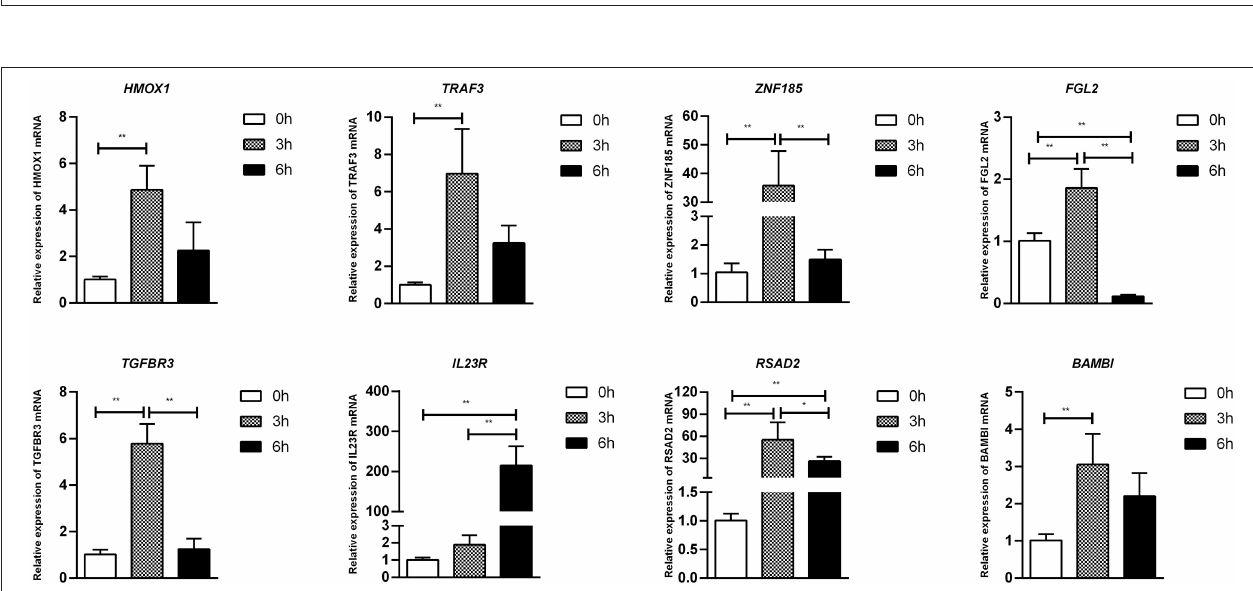
FIGURE 6 | Validation of mRNA differential expression results during SE infection in duck granulosa cells at 0, 3, and 6 hpi. qRT-PCR validation of HMOX1 , TRAF3 , ZNF185 , FGL2 , TGFBR3 , IL23R , RSAD2 , and BAMBI mRNA expression levels in cell samples between 0, 3, and 6 hpi. The mRNA expression levels at 3 and 6 hpi were normalized to the value at 0 hpi. Error bars indicate the mean ± SD of triplicate experiments. β -actin was used as as reference gene. * P < 0.05; ** P < 0.01.